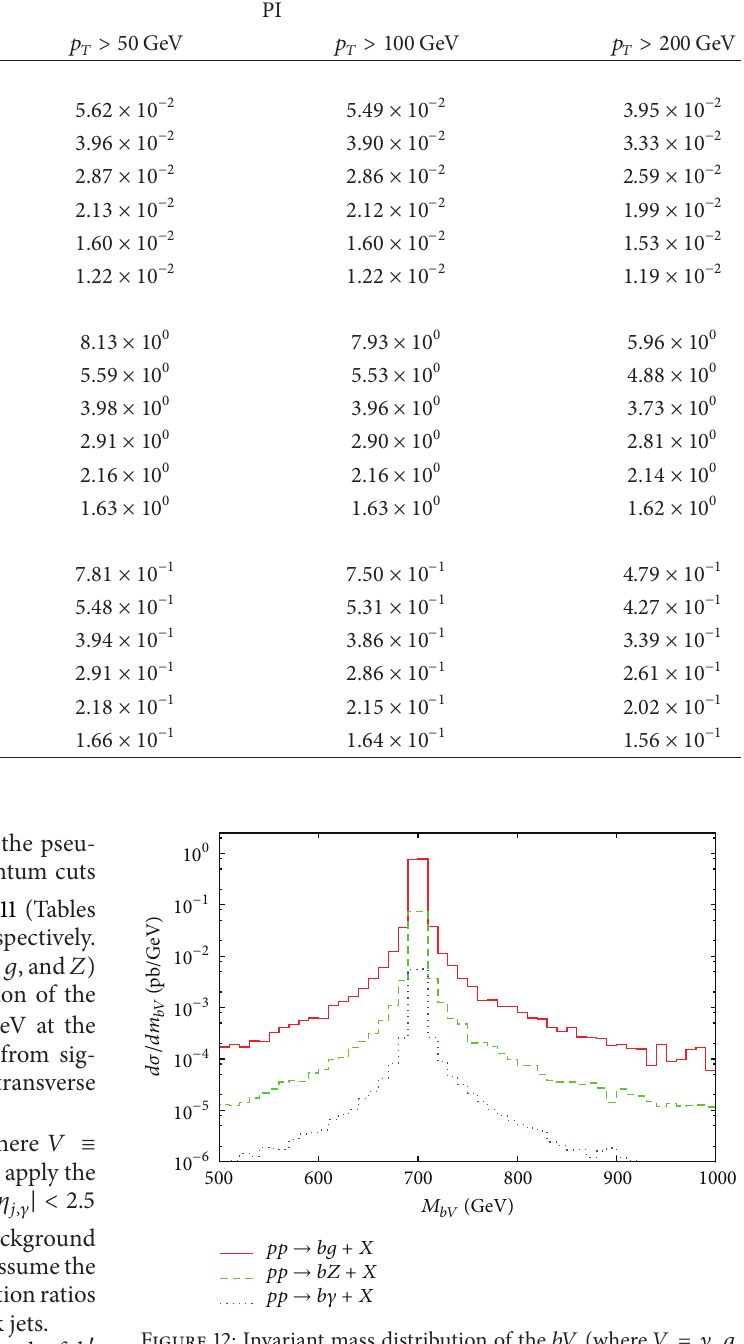
Figure 12: Invariant mass distribution of the 𝑏𝑉 (where 𝑉 = 𝛾 , 𝑔 , and 𝑍 ) system is shown in Figure 5 for PI parametrization of the signal with 𝜅/Λ = 0.2 TeV −1 and 𝑚 𝑏 󸀠 = 700 GeV at the center of mass energy √ 𝑠 = 13